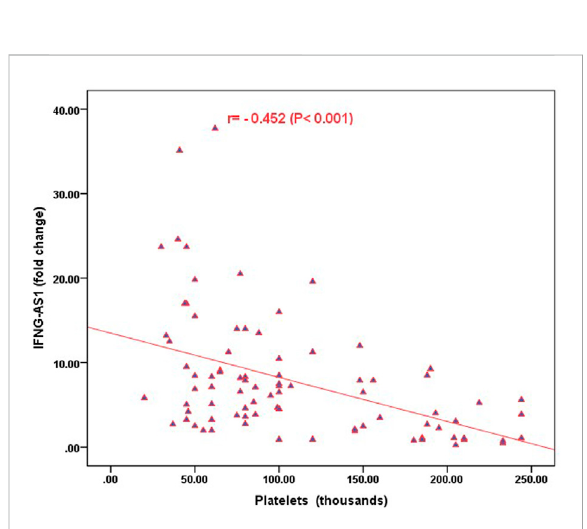
FIGURE 3 Correlation analysis betweentheexpressionof IFNG-AS1 and platelet count after treatment. There was a negative correlation between IFNG-AS1 fold change and platelet count after treatment ( r = -0.452, p < 0.001).